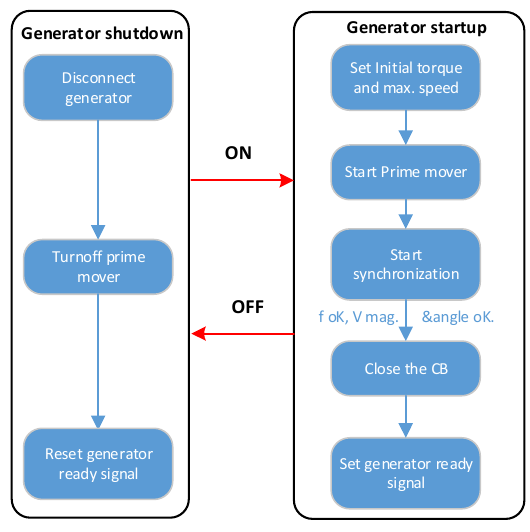
Figure 13. Power controlled generator control.